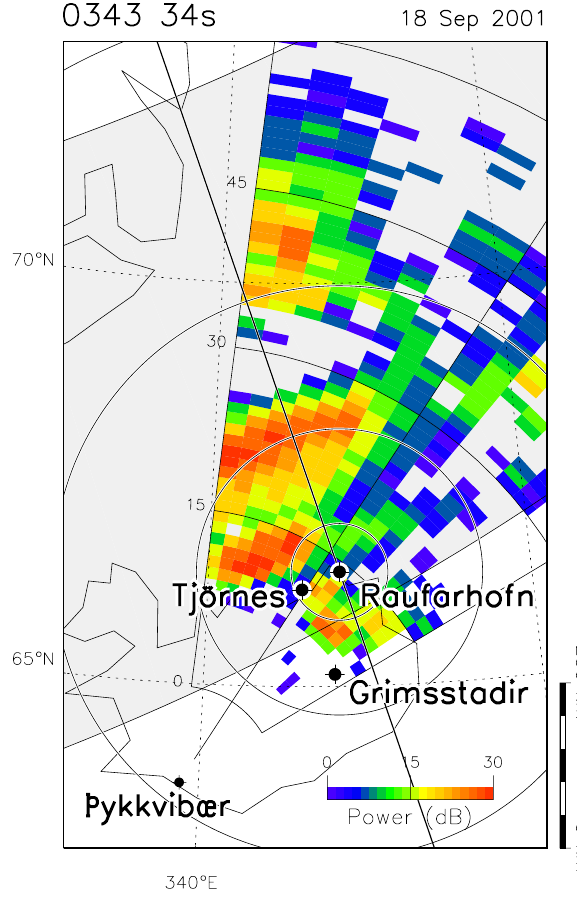
Fig. 1. A map showing the vicinity of Iceland and southeast- ern Greenland, indicating the location of the Pykkvibær radar and the three all-sky camera sites. The radar field-of-view is mapped assuming a backscatter altitude of 110km. Colour-coded is the backscatter power from the radar scan starting 03:43:34 UT on 18 September 2001. The projection of the Raufarhofn ASC field-of- view is shown, the four concentric circles marking the locii of zenith angles of 30 ◦ , 60 ◦ , 75 ◦ and 85 ◦ mapped to an altitude of 110km. The geomagnetic meridian employed to produce keograms is also shown. Superimposed is the statistical auroral oval for a K p level of